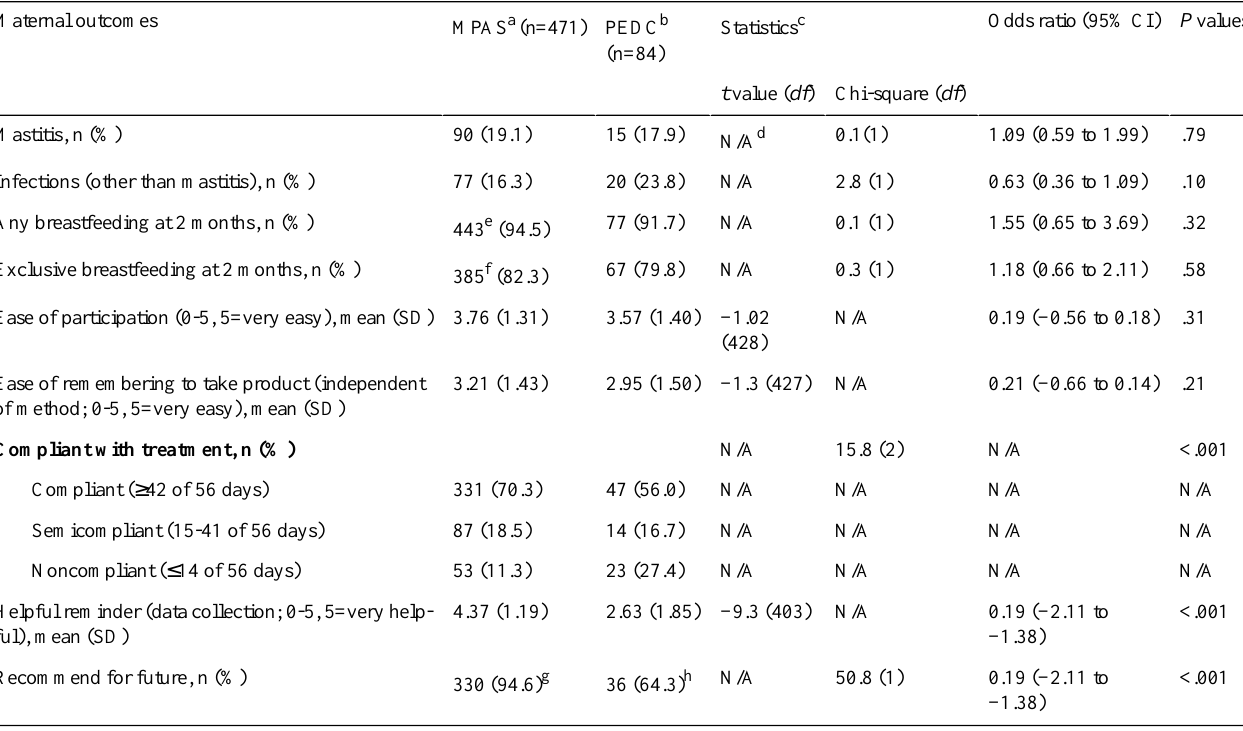
Table 2. Impact and acceptability of the mobile phone automated system compared with the paper and email data collection